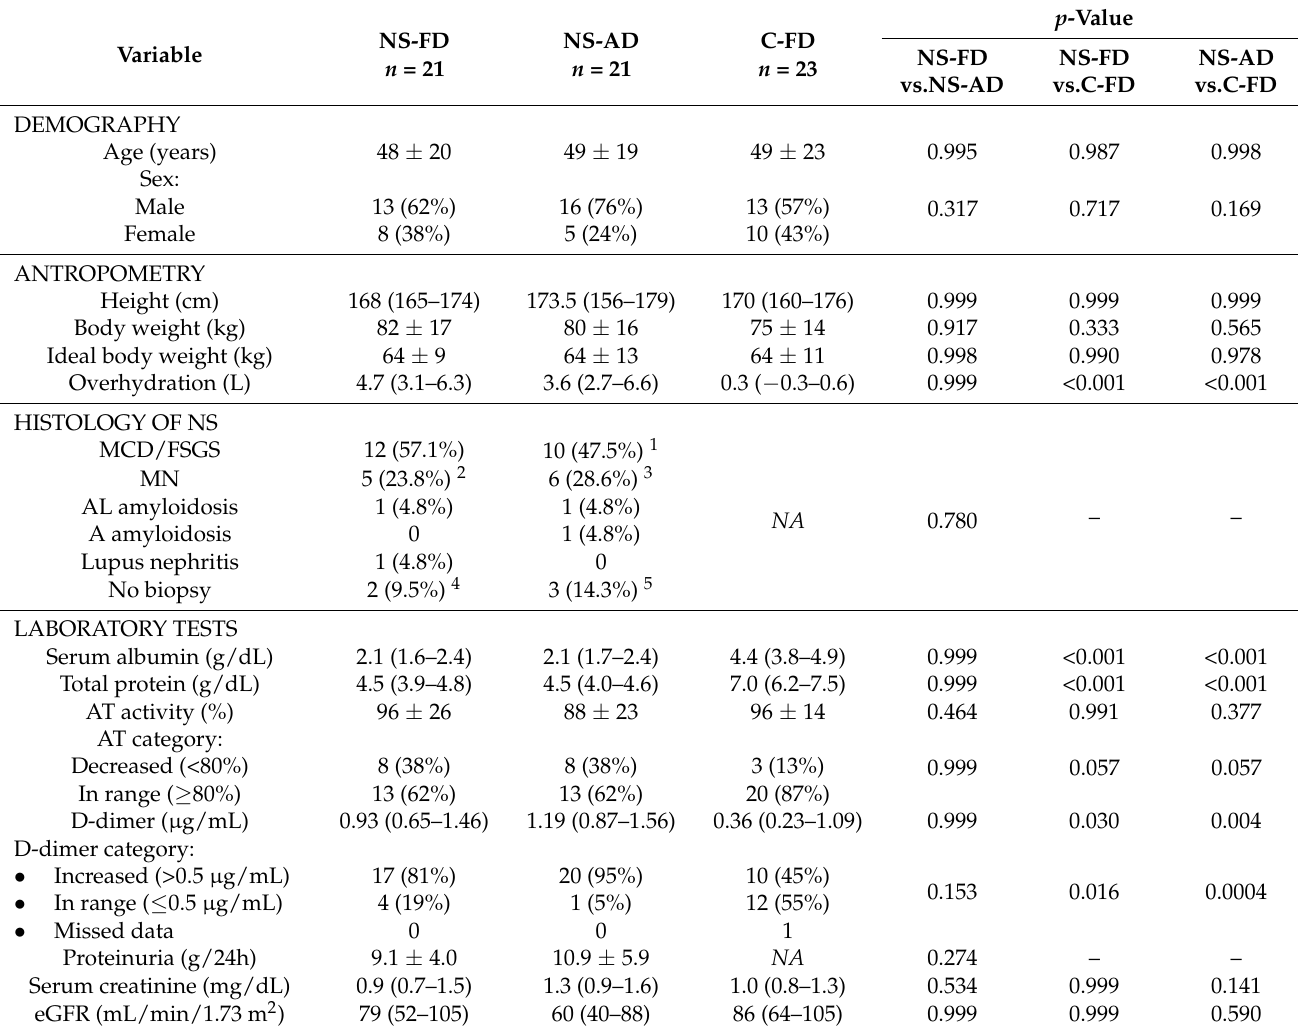
Table 1. Characteristics of the study